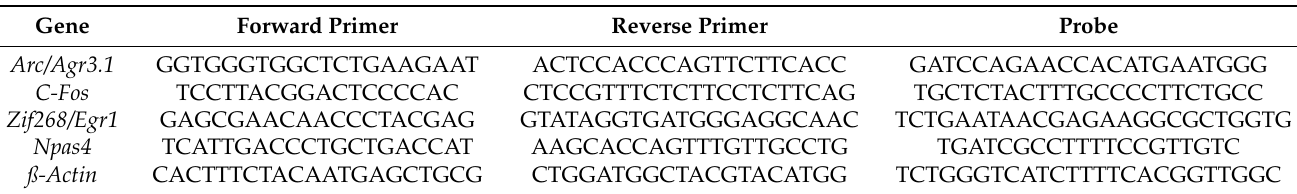
Table 1. Sequences of Forward and Reverse primers and probes used in qRT-PCR